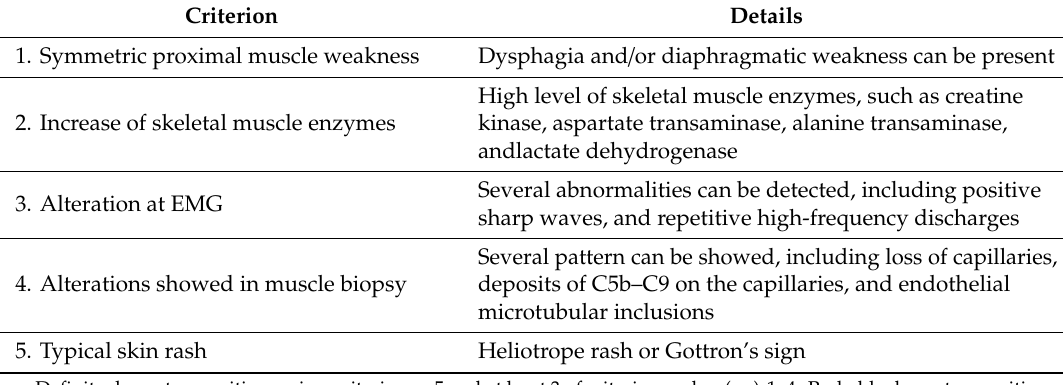
Table 5. Diagnostic criteria for dermatomyositis proposed by Bohan and